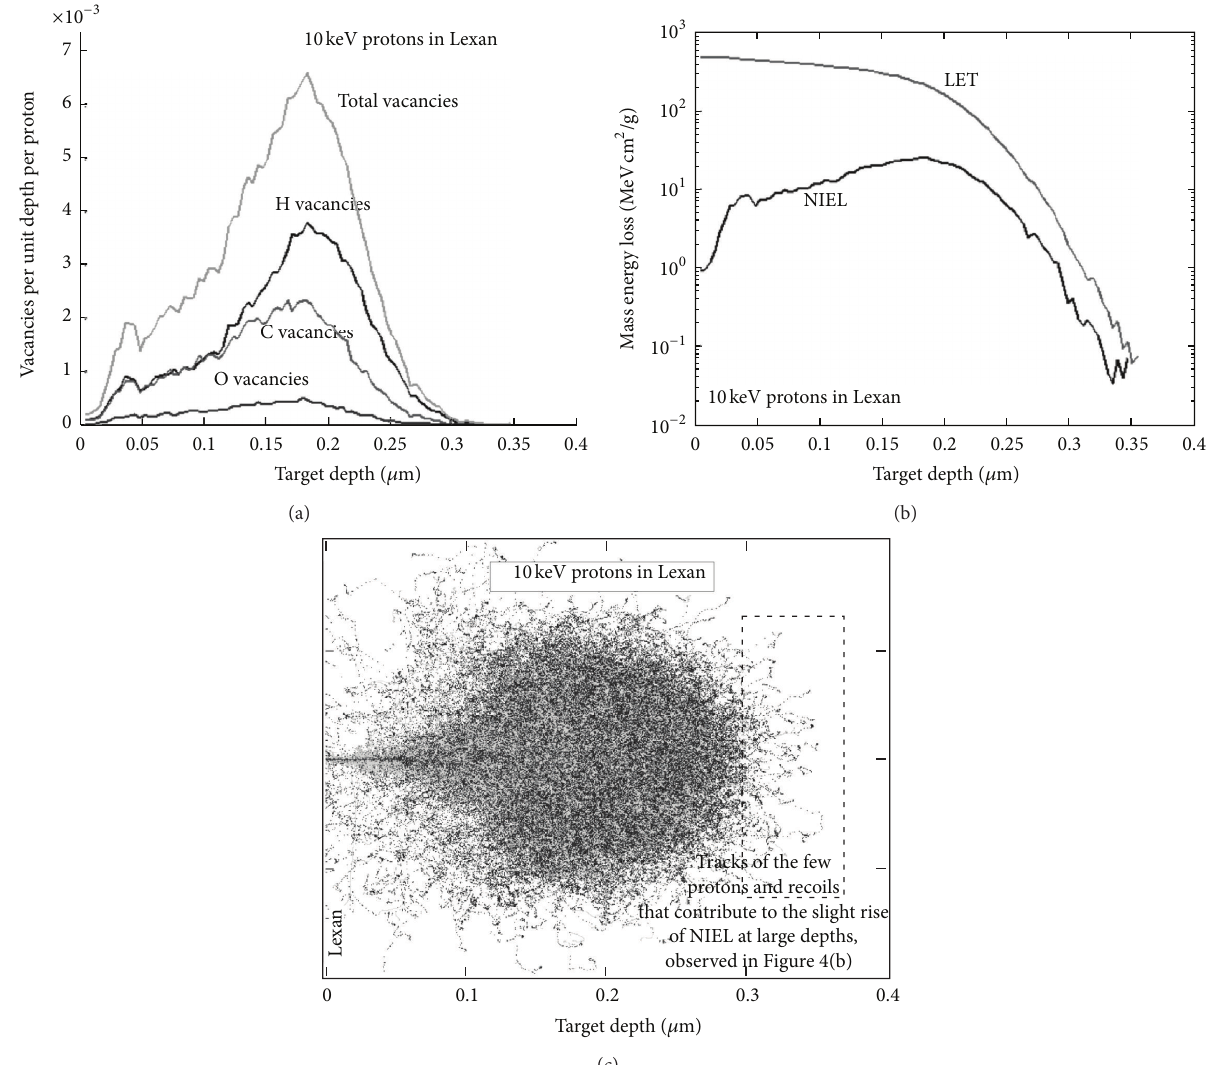
Figure 4: Plots of (a) vacancy concentrations and (b) mass energy losses (LET and NIEL divided by material density) along the depth of a 0.4 𝜇 m thick lexan (polycarbonate) film. (c) Tracks of protons and recoiling atoms. Results were obtained from simulations of 10 4 proton histories, for a 10keV incident proton